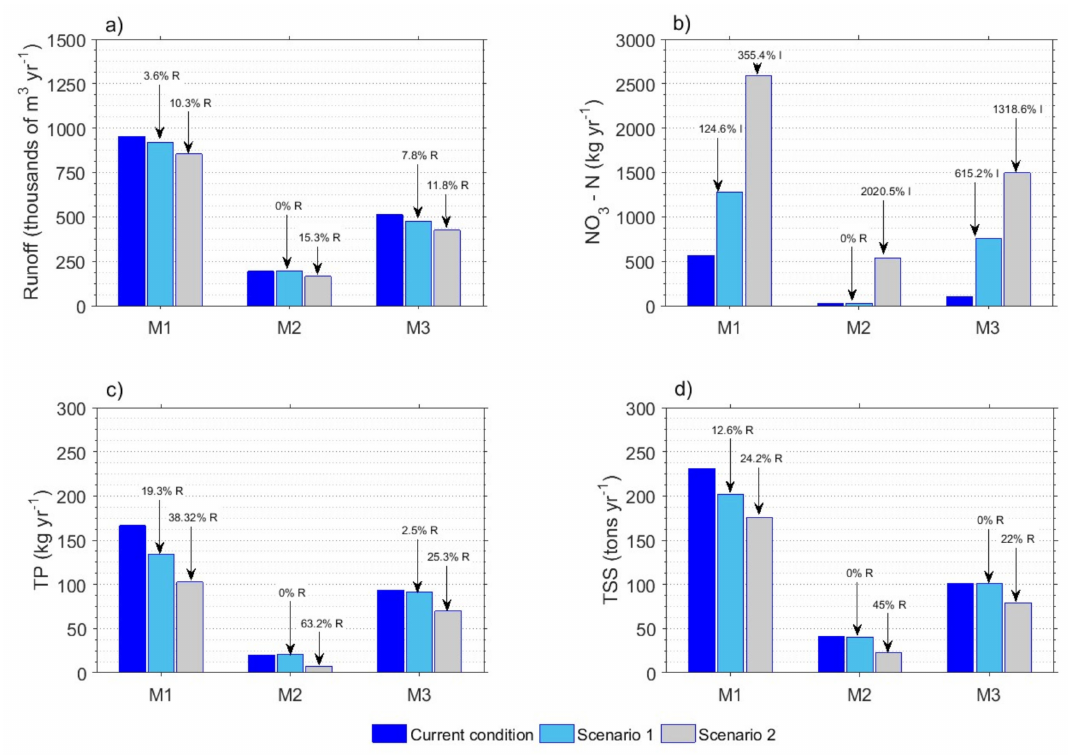
Figure 9. Impacts of two additional agricultural management operations in the simulated watershed on the average of ( a ) total annual runo ff production, ( b ) NO 3 –N load, ( c ) TP load, and ( d ) sediment load. Text arrows indicate the reduction or increase percentage relative to the current condition